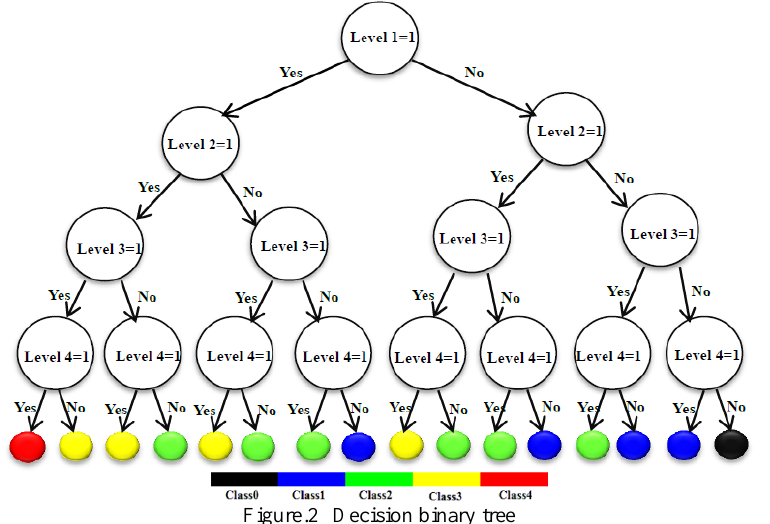
Figure.2 Decision binary